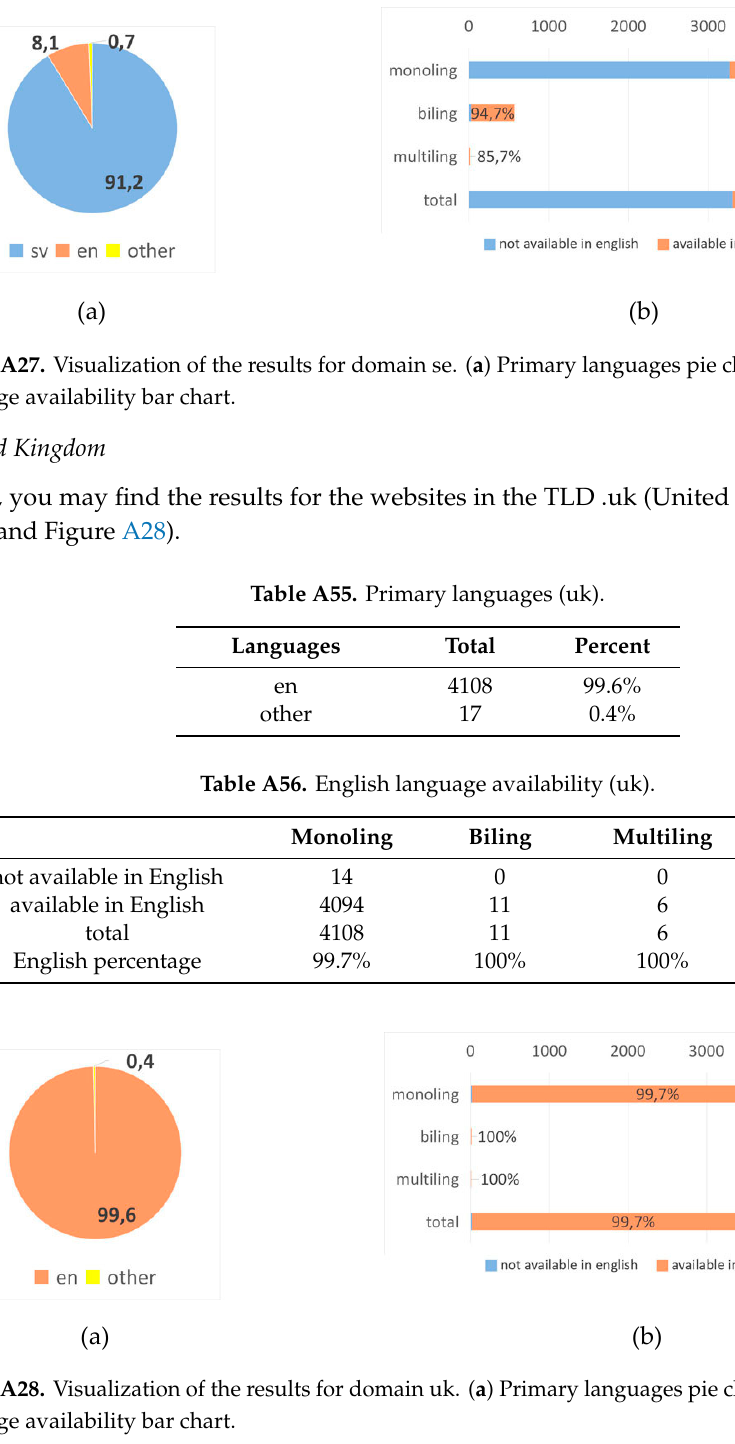
Table A53. Primary languages (se). Languages